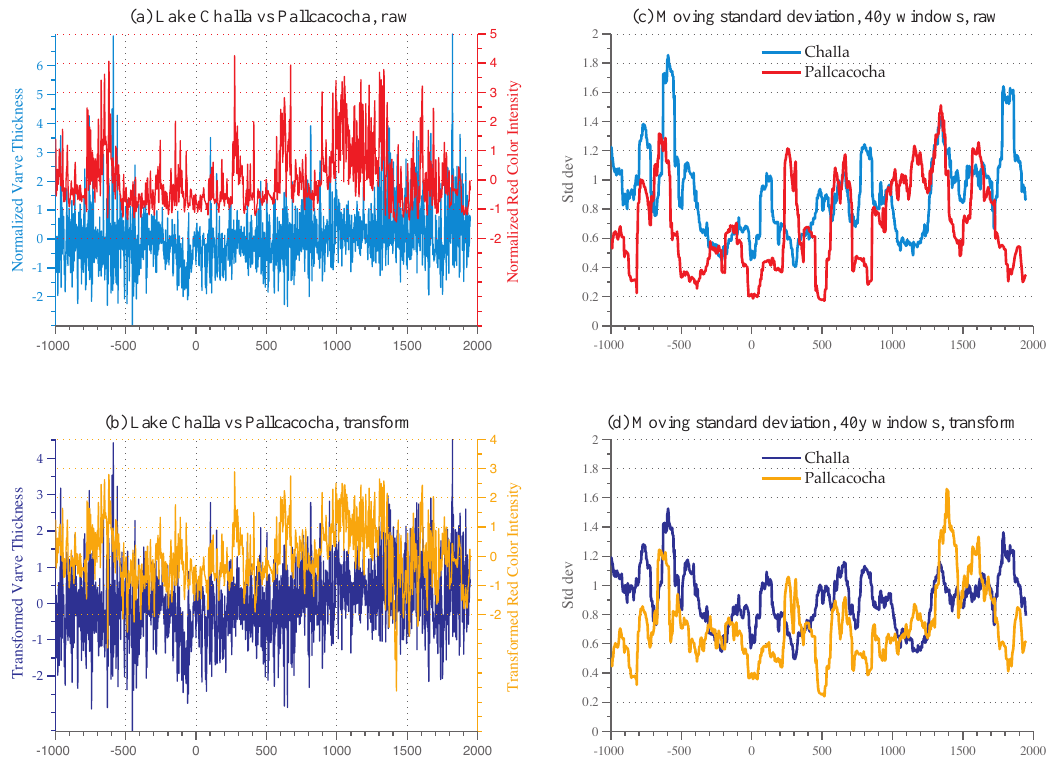
Figure 11. Comparison of Lake Challa and Laguna Pallcacocha records. Top row: raw (untransformed) records. Bottom row: transformed records. Left: time series interpolated at biannual resolution. Right: standard deviation on sliding 40yr